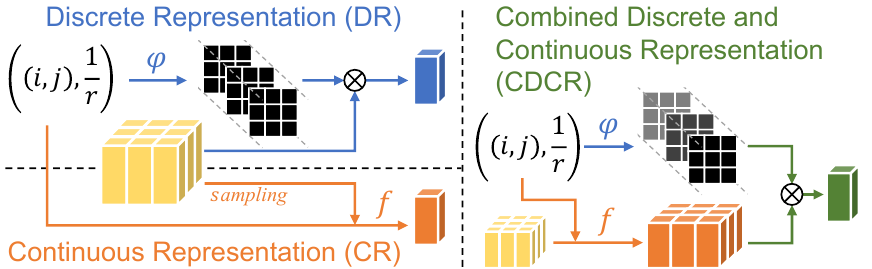
Figure 1. Flows of discrete representation (DR), continuous representation (CR), and combined discrete and continuous representation (CDCR). The coordinate of the high-resolution image is represented by ( i , j ) , and the scale factor is represented by r . The function ϕ is designed to predict the convolution kernel, while the function f directly maps from the coordinates to signals. In CDCR, the function ϕ predicts a modulated filter that embeds the predicted values into a specified